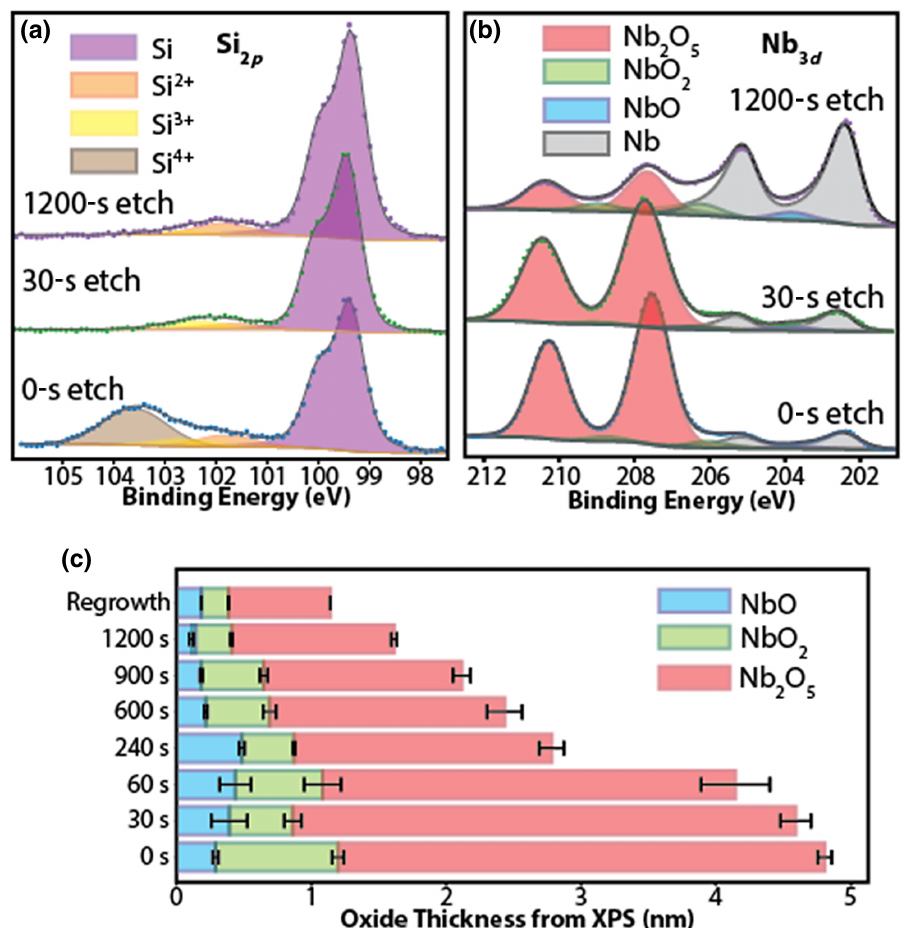
and Fig. 12. The other bars are resonator experiments. The NbO layer (blue, on the left) is closest to the Nb metal, while the Nb 2 O 5 layer (red, on the right) is exposed to air. The error bars show point- to-point variations across each